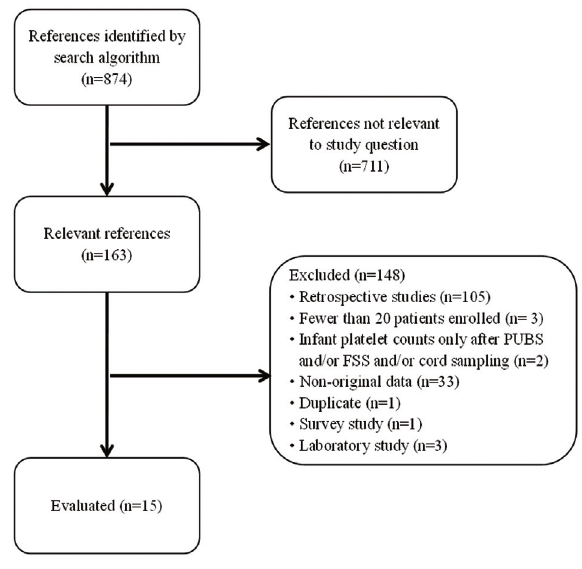
Fig. 1 Flow diagram for selection of